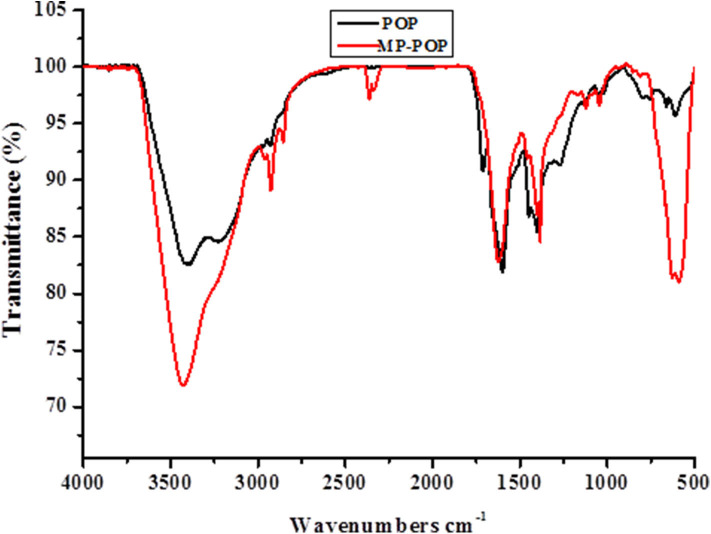
FTIR spectra of POP and MP-POP.